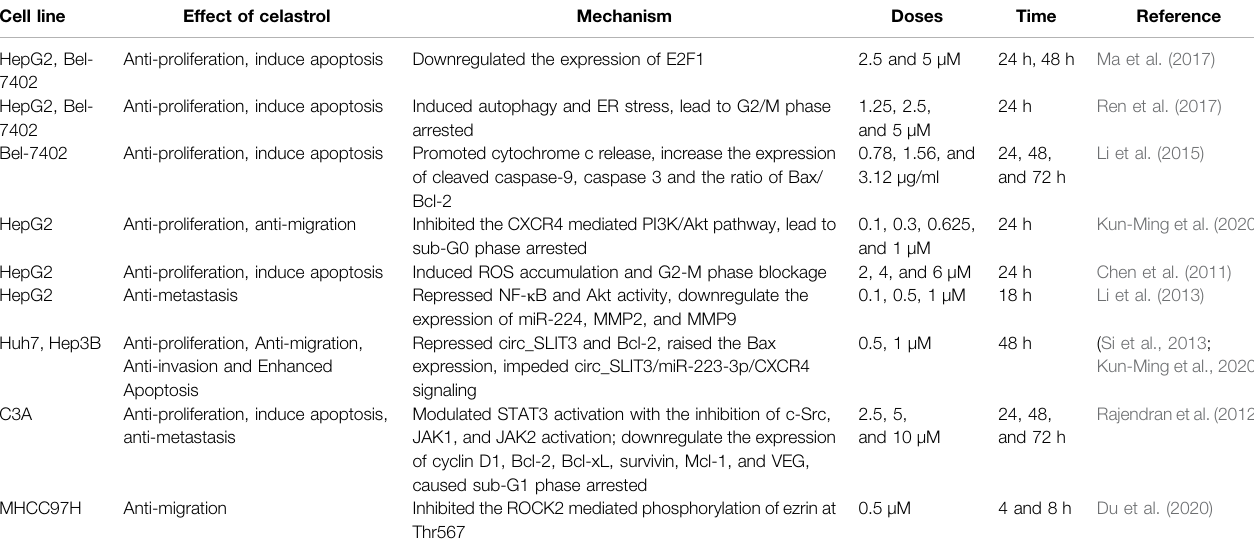
TABLE 4 | Anti-cancer effects of celastrol in vitro .